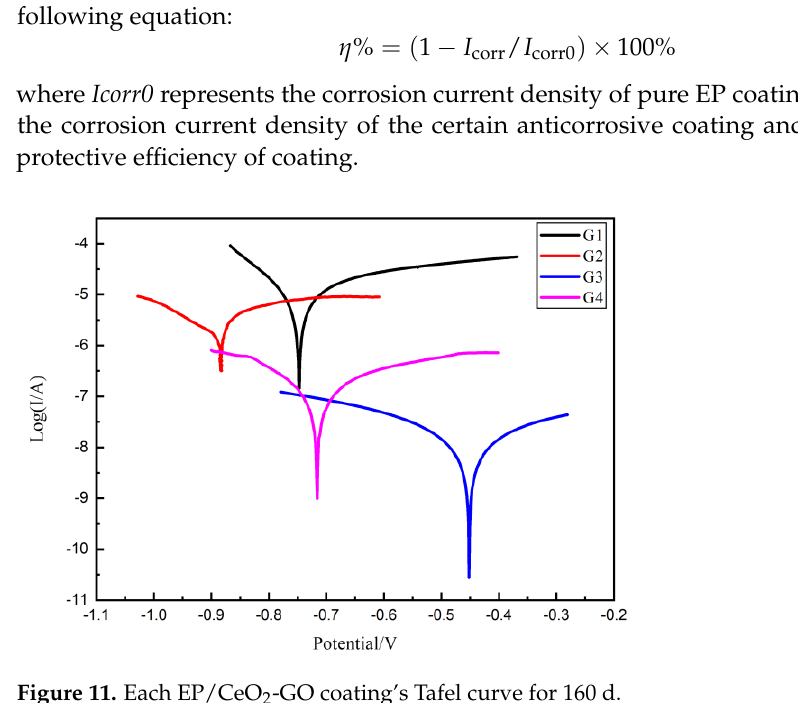
Table 2. Kinetic parameters of each coating.